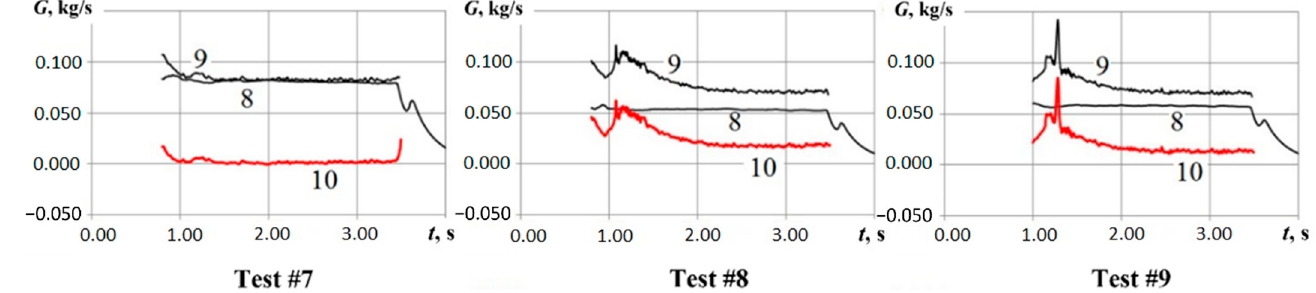
Figure 11. Calculated time histories of flow rates G in (curve 8), G out (9) and ∆ G = G out ( t ) − G in ( t ) (10)